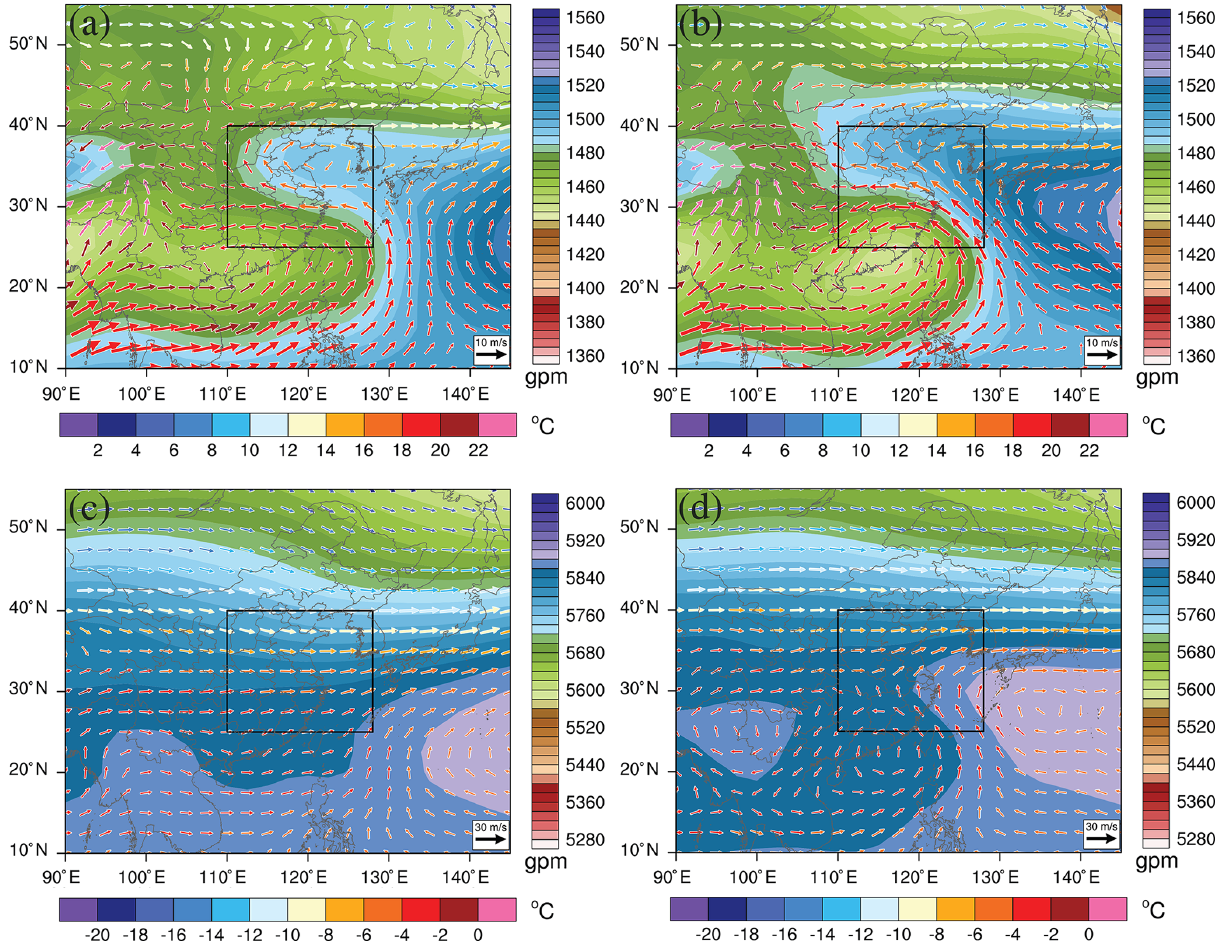
Figure 7. The geopotential height (shaded) and 850hPa wind with temperature (color vector) under (a) SWP4_Pos and (b) SWP4_Neg. The geopotential height (shaded) and 500hPa wind with temperature (color vector) under (c) SWP4_Pos and (d) SWP4_Neg. The boxed area in panels (a) – (d) encloses the